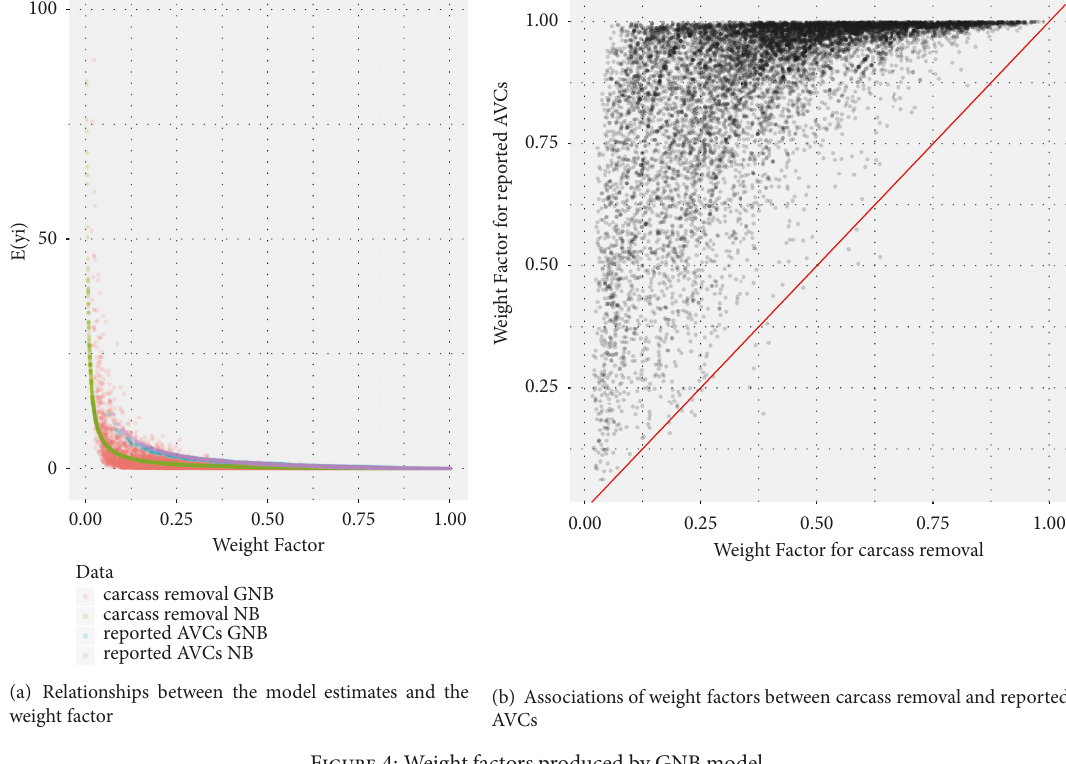
Figure 4: Weight factors produced by GNB model.